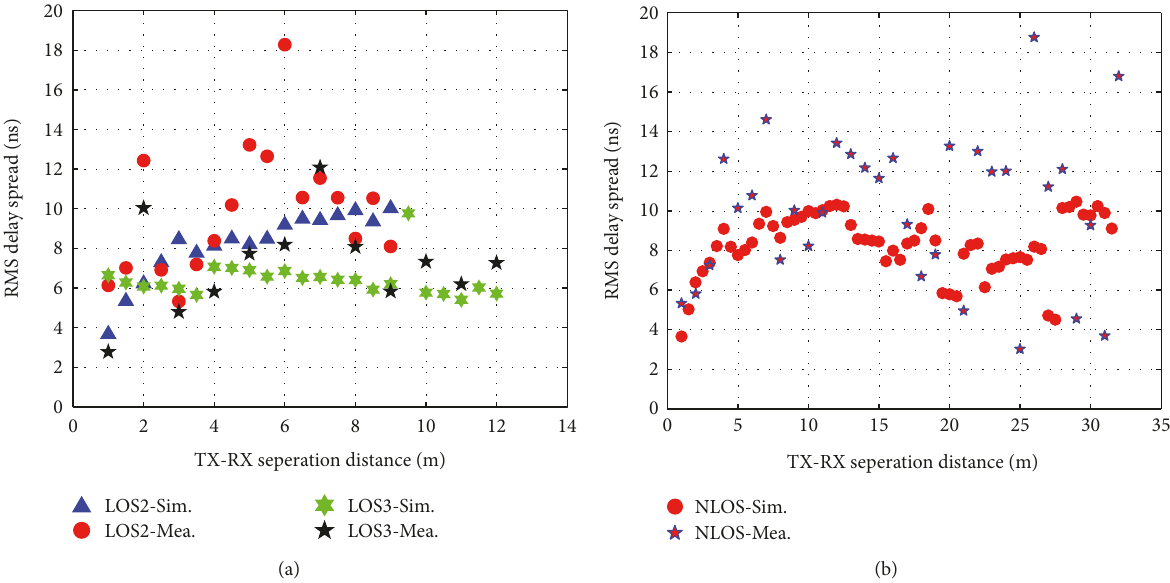
Figure 5: RMS delay spread variation with TX-RX separation distance in LOS and NLOS tunnel scenarios. (a) LOS-2 and LOS-3 paths and (b) NLOS